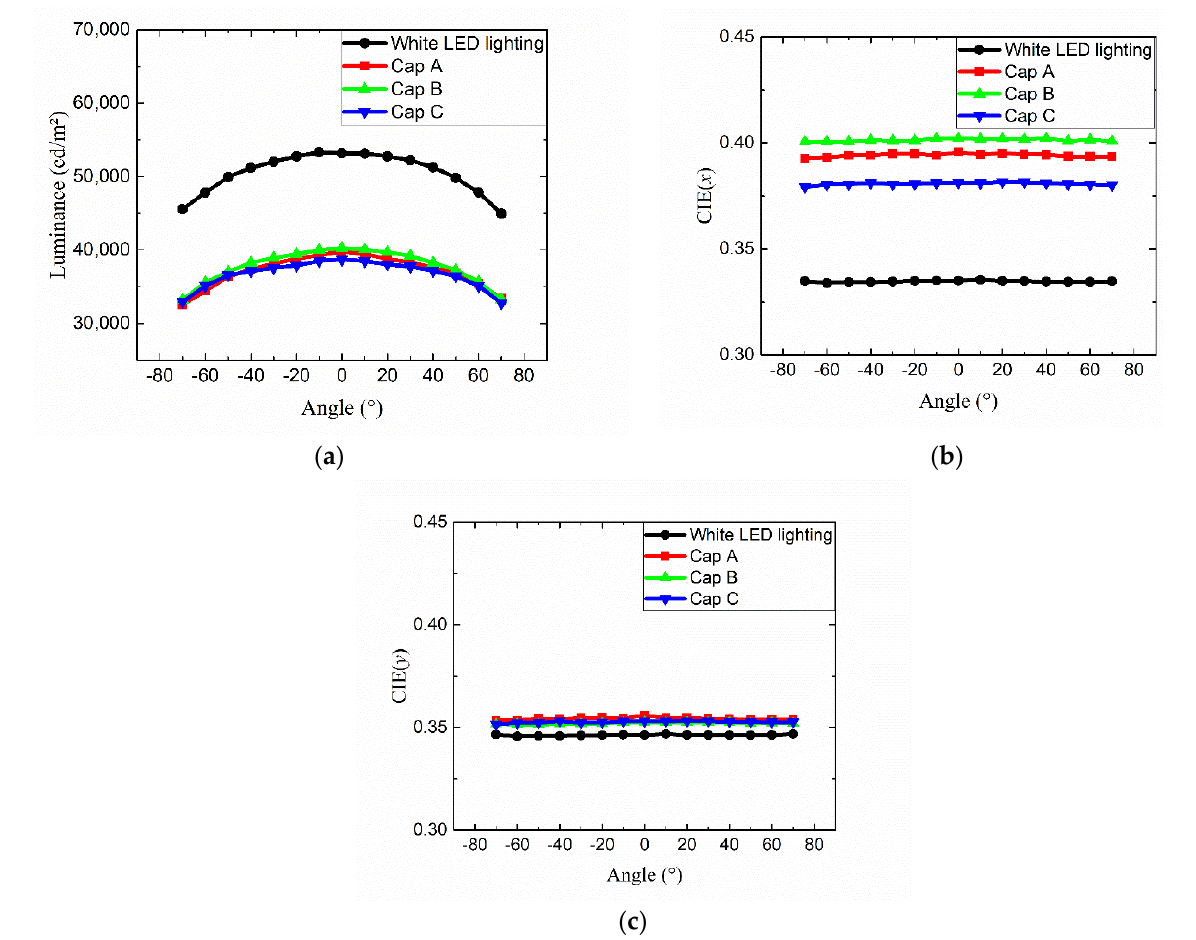
Figure 9. Angular dependence of ( a ) the luminance and the color coordinates ( b ) x and ( c ) y for the four configurations where no cap and cap A, B, and C were used.